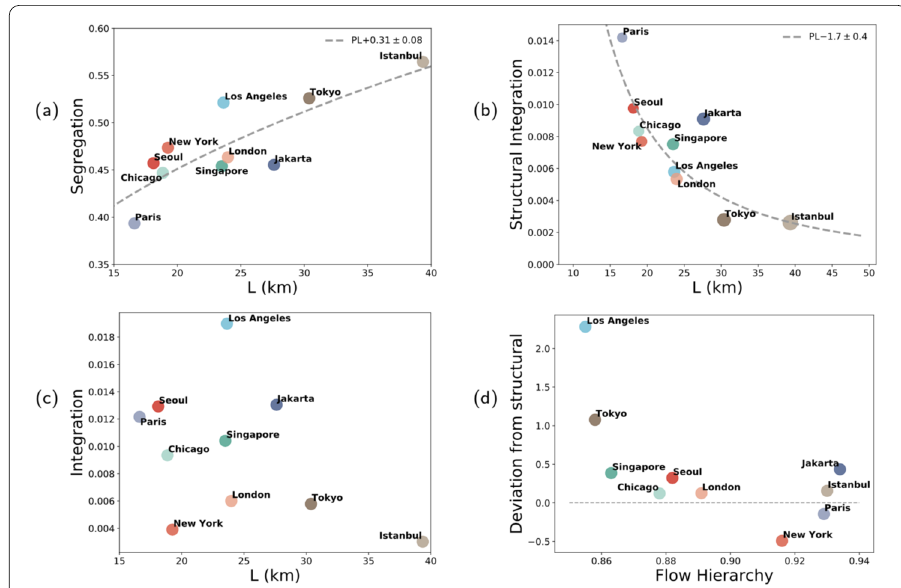
Figure 4 Understanding Functional Segregation and Integration. While the functional segregation ( a ) and structural integration ( b ) show a clear dependency over city size, functional integration ( c ) is not simply determined by how big is a city. In ( d ), we plot the deviation between functional and structural integration, computed as ( GCE funct – GCE struc )/ GCE struct vs the values of flow hierarchy for the same cities computed in [74] from another